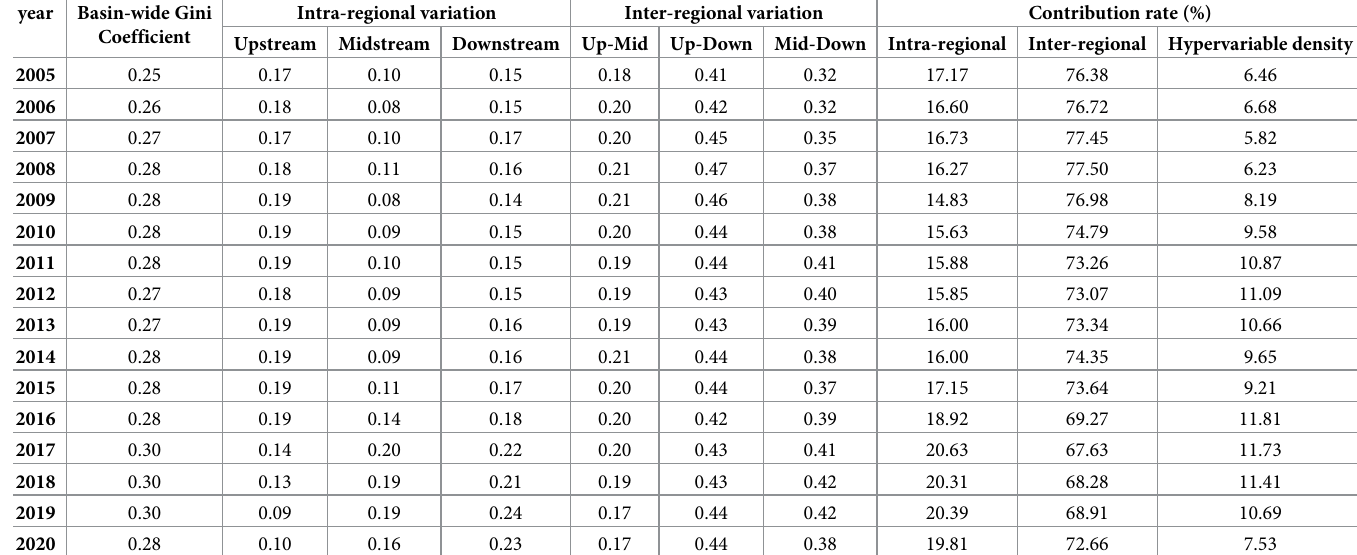
Table 1. Dagum Gini coefficient and decomposition. year Basin-wide Gini